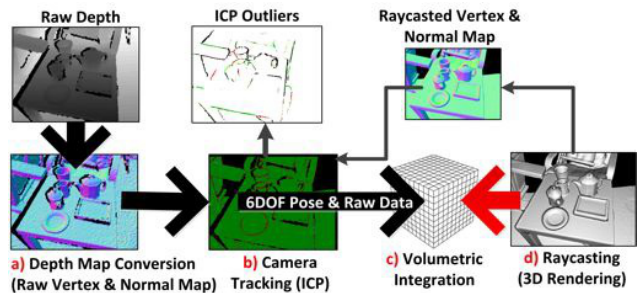
Fig. 2. Overview of KinectFusion’s pipeline